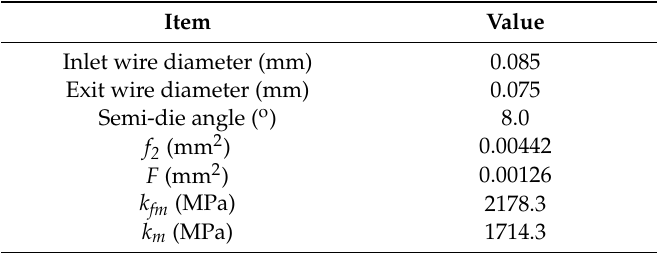
Figure 5. Equipment (Instron 5566A) for measuring the drawing load. Table 2. One pass drawing experiment conditions for measuring the friction coefficient ( μ ).